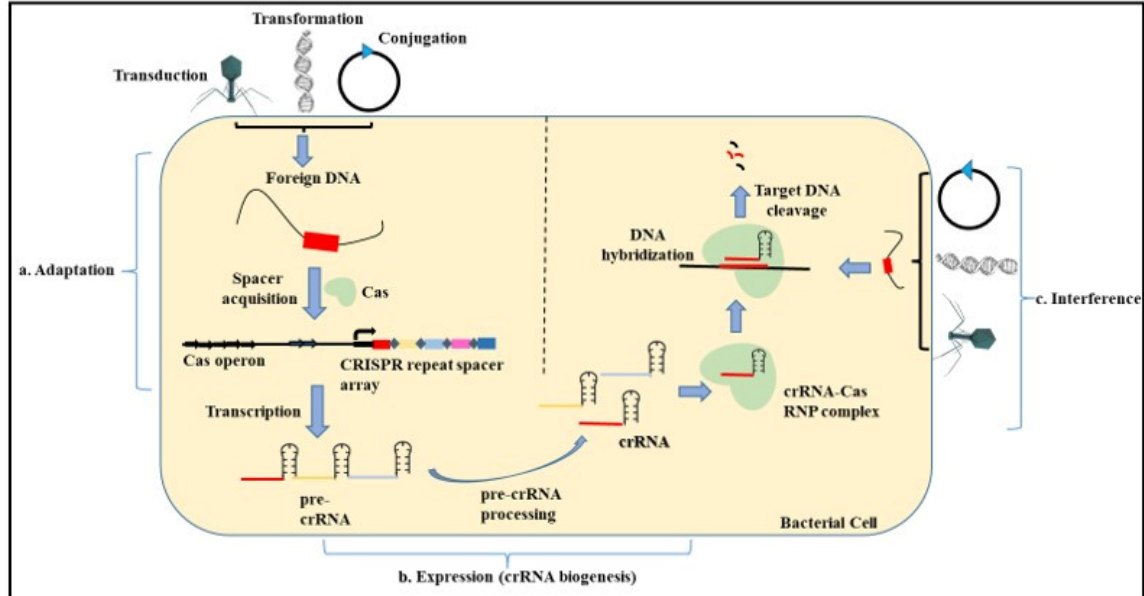
Figure 3. Mechanism of microbial CRISPR Cas System. The mechanism of the CRISPR Cas system involves three main steps. ( a ) Adaptation. In this step, the exogenous DNA is cleaved, followed by the recognition of the proto-spacer adjacent motif (PAM). This proto-spacer is then processed into a pre-spacer having the last PAM nucleotide. The leader end repeat sequence in the CRISPR locus is cleaved followed by the pre-spacer being integrated along with duplication of the repeats flanking the spacer. ( b ) Expression. This step involves the biogenesis of the CRISPR RNA (crRNA) by the transcription of the CRISPR locus containing the spacer sequence. First, the primary CRISPR transcript called the pre-crRNA is generated. These transcripts are further processed by different proteins to give rise to a mature crRNA that contains spacer sequences flanked by partial repeats. ( c ) Interference. In this step, the mature crRNA complexed with the Cas nucleases guides the Cas machinery to the complementary sequences present on the invading nucleic acid. The binding of the crRNA to the homologous sequences leads to the cleavage of the foreign DNA.